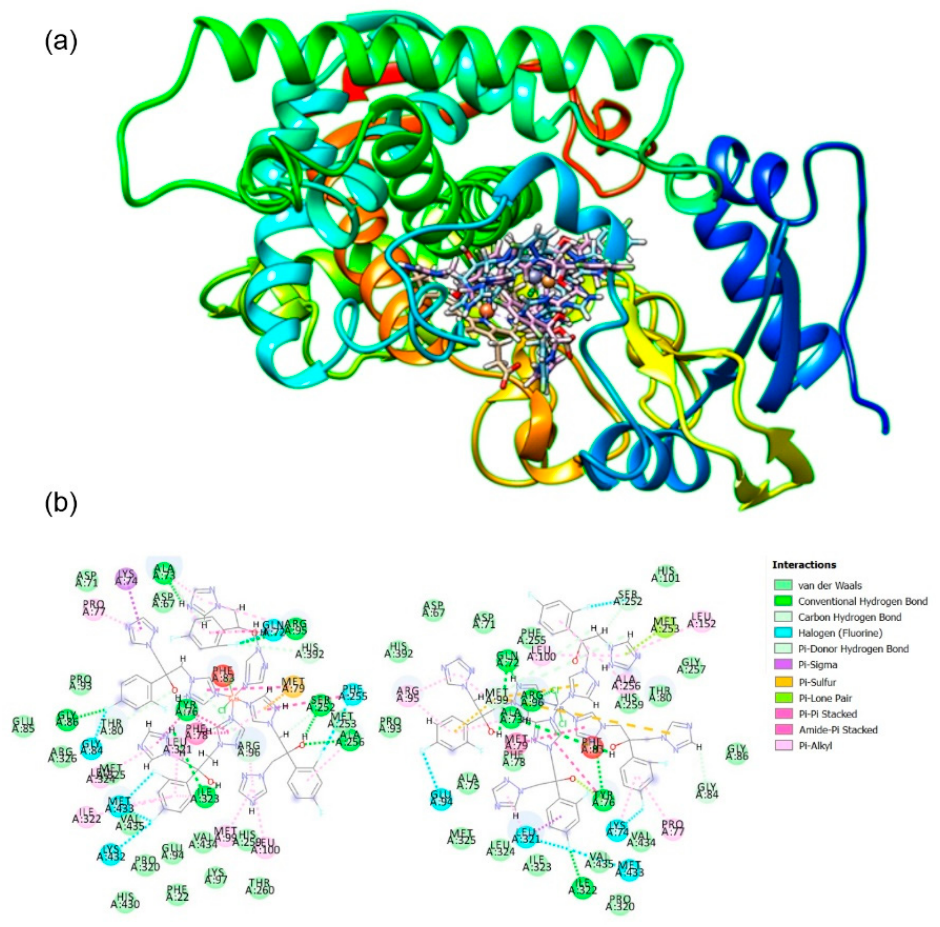
Figure 8. Molecular docking of complexes 1 and 2 and CYP51. ( a ) Best calculated poses for the complexes 1 and 2 inside the active site of CYP51 (PDB 1EA1); ( b ) Two-dimensional representation of calculated interactions between complex 1 ( left ) and complex 2 ( right ) and amino acids from the enzyme active site.